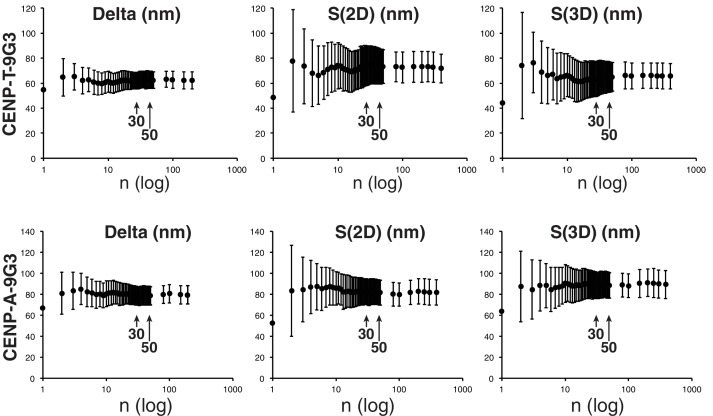
About 10 ~15 kinetochore measurements are sufficient to obtain a mean value close to the mean separation values ± SD from>200 kinetochores.Plots of mean Delta, S(2D), and S(3D) versus sample number (n, log) for separations between CENP-T and Hec1-9G3, and between endogenous CENP-A and Hec1-9G3.